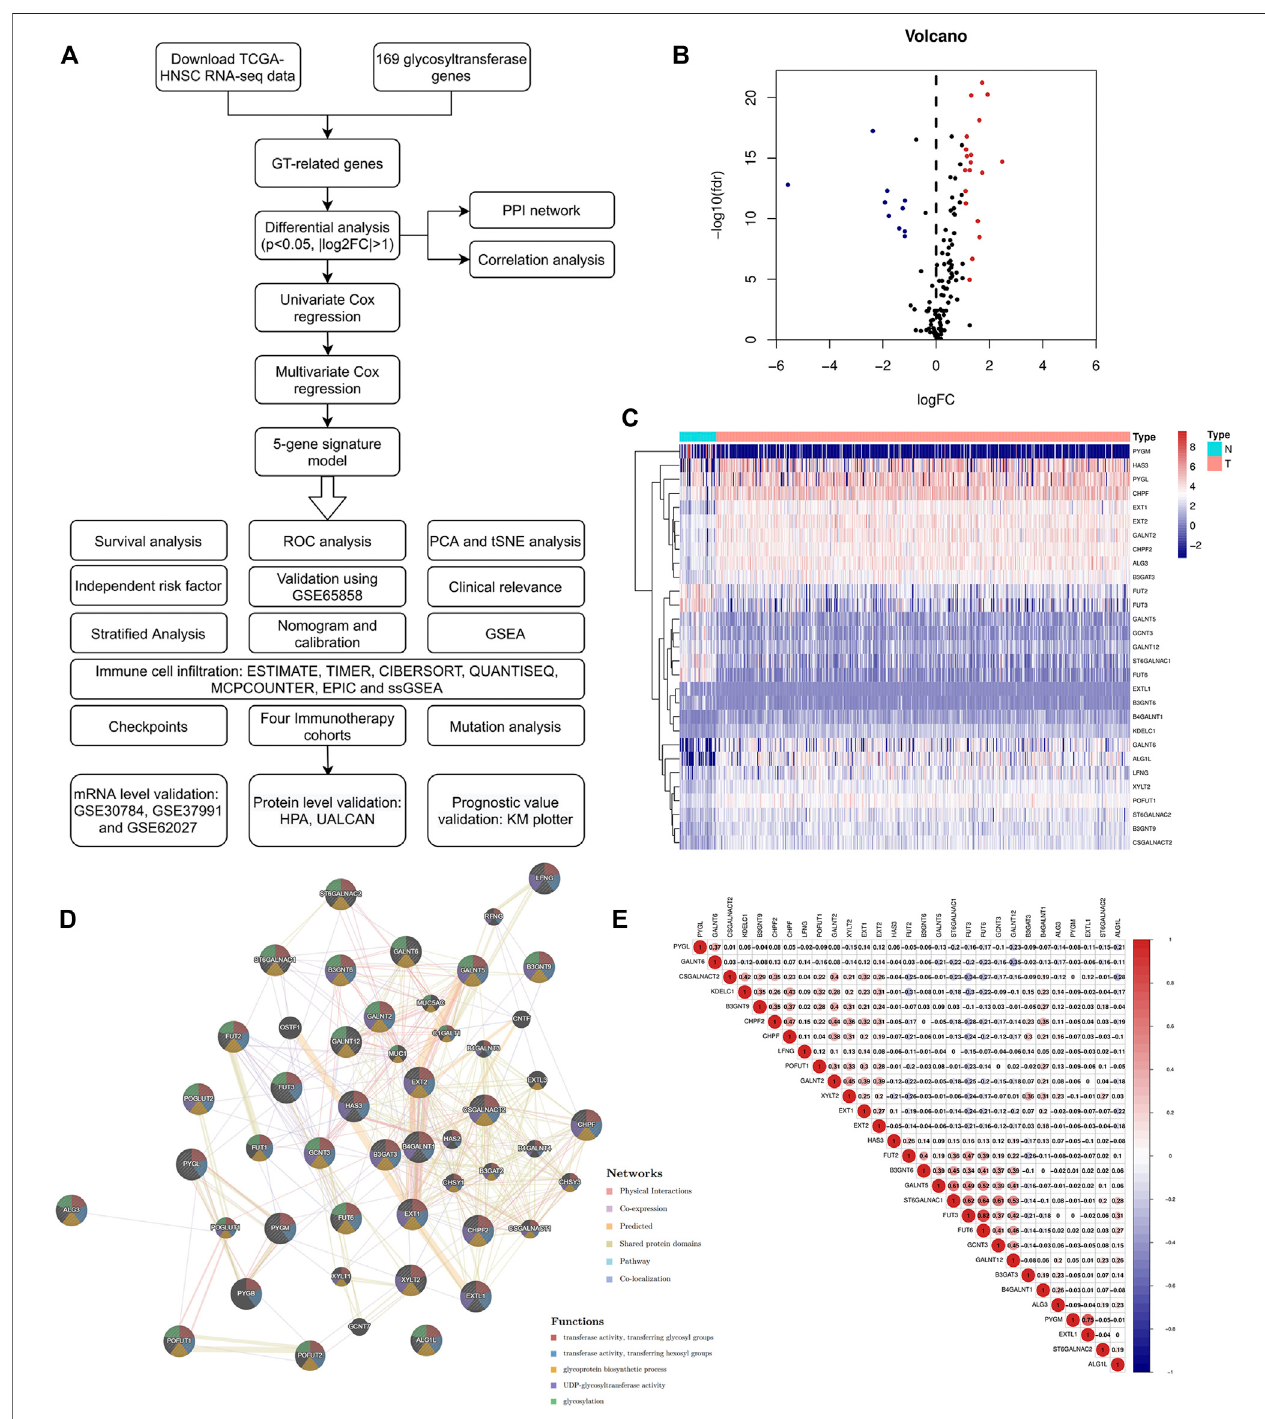
FIGURE1| Identi fi cation ofDE-GTRGsbetween44 normal and 495HNSCC tissues. (A) Brief fl ow chart ofthisstudy. (B) Volcano plotof29 DE-GTRGs inTCGA- HNSCC. Red means upregulated and blue means downregulated genes. (C) Heatmap of DE-GTRGs between normal and HNSCC tissues. (D) PPI network based on the DE-GTRGs using the GeneMANIA database. (E) Correlation of the expression of DE-GTRGs in HNSCC tissues. DE-GTRGs, differentially-expressed glycosyltransferase-related genes; HNSCC, head and neck squamous cell carcinoma; TCGA, The Cancer Genome Atlas; PPI, protein – protein interaction.